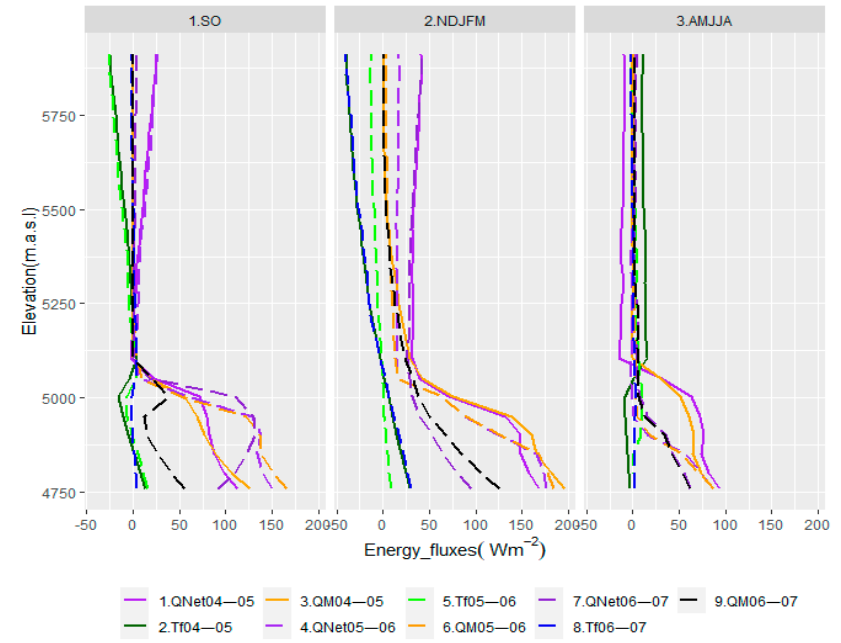
Figure 9. Vertical profiles of elevation-band averaged energy flux terms for melting, net radiation and turbulent fluxes for the three seasons September–October (SO), November–March (NDJFM), and April2August (AMJJA) for each of the hydrological years 2004–2007.